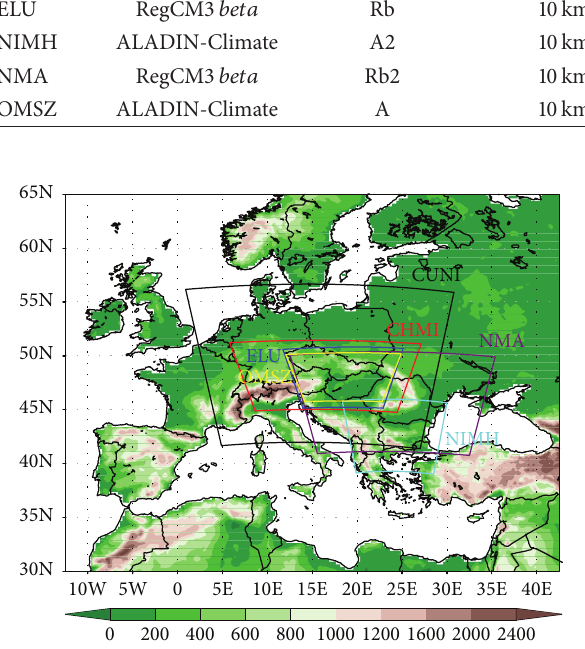
Figure 1: Integration domains of CECILIA simulations; shading: orography from E-OBS